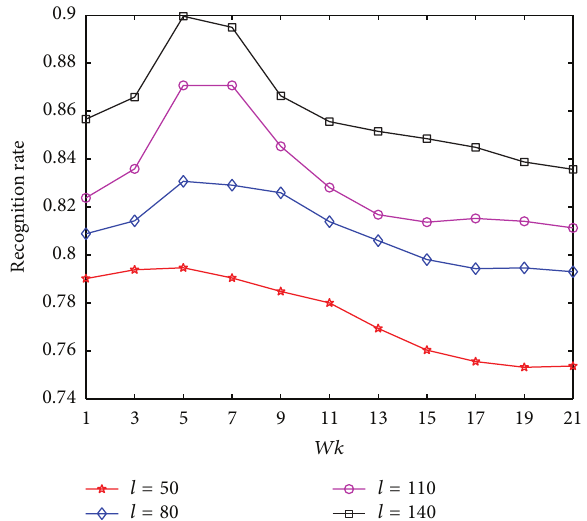
Figure 10: The average recognition rates of MNMDP versus 𝑊𝑘 on